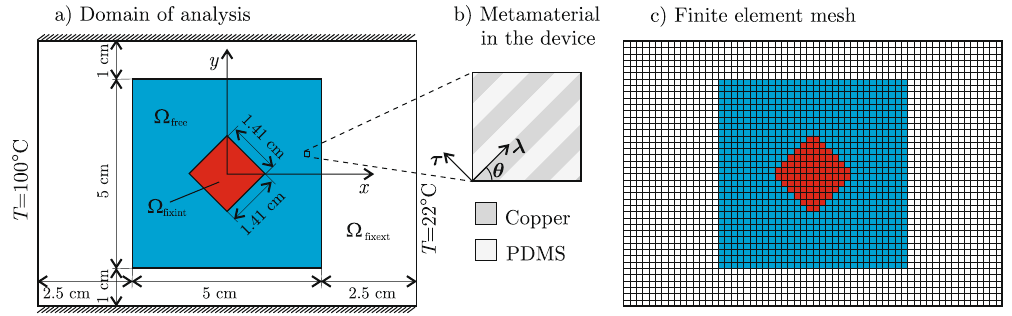
Figure 2. Validation example: ( a ) domain of analysis, ( b ) metamaterial used to build the device, ( c ) finite element mesh of Ω ; the blue elements belong to the device, and the red ones have heat flux prescribed to be